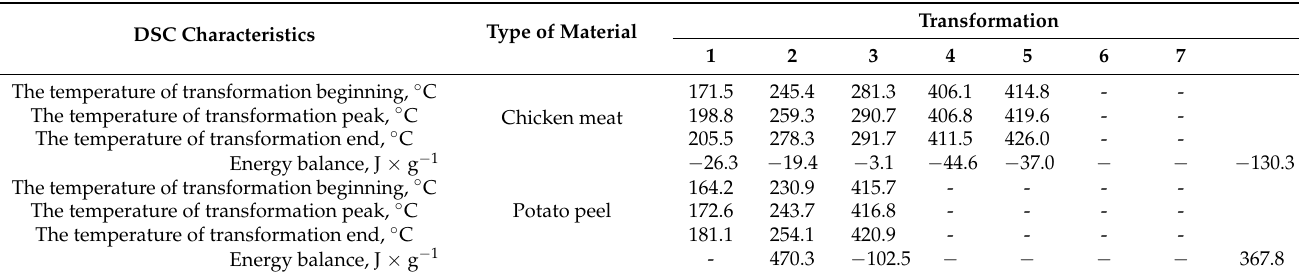
Table 8. Normalized transformation energy for successive transformations of tested biodegradable waste and energy balance of the process. DSC